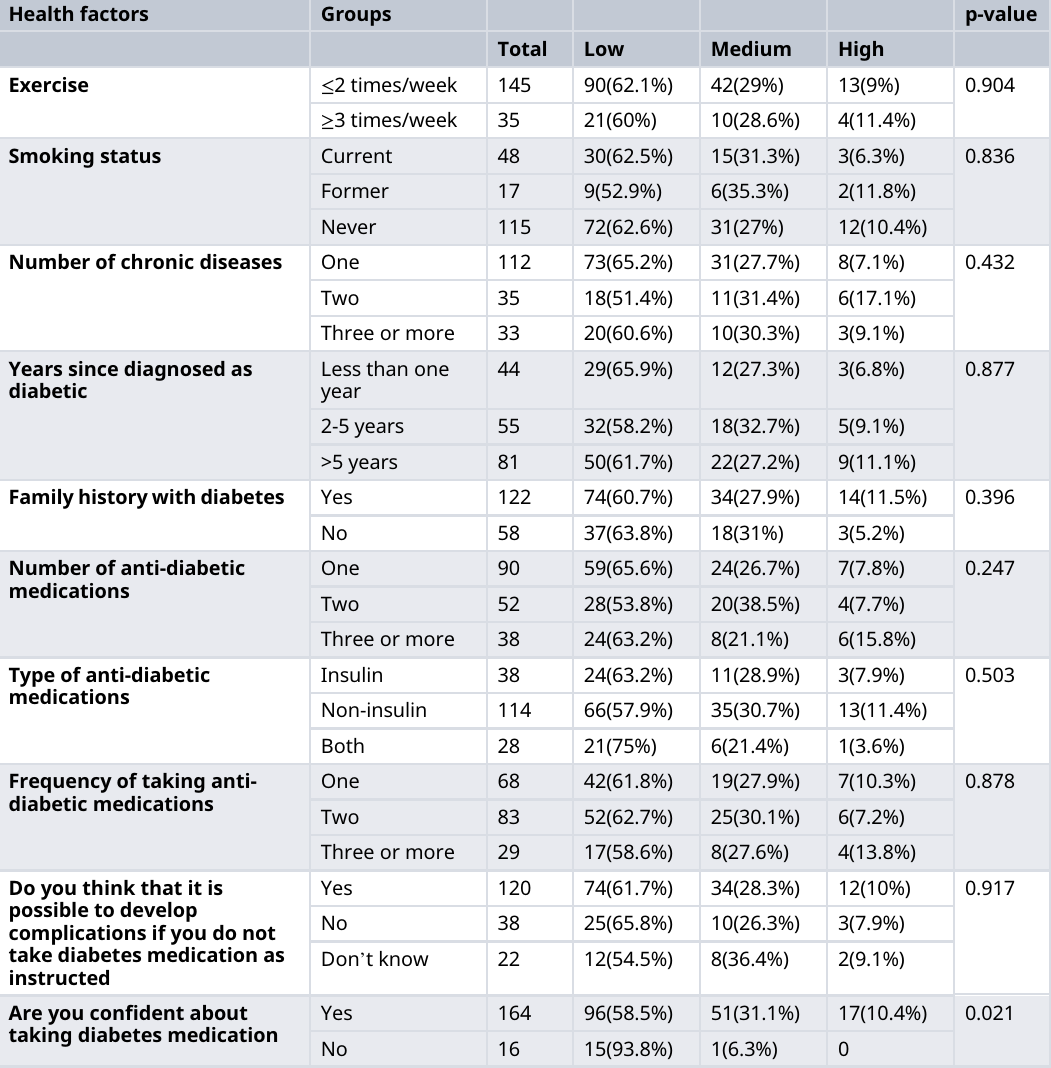
Table 5. Medication adherence according to life style and health